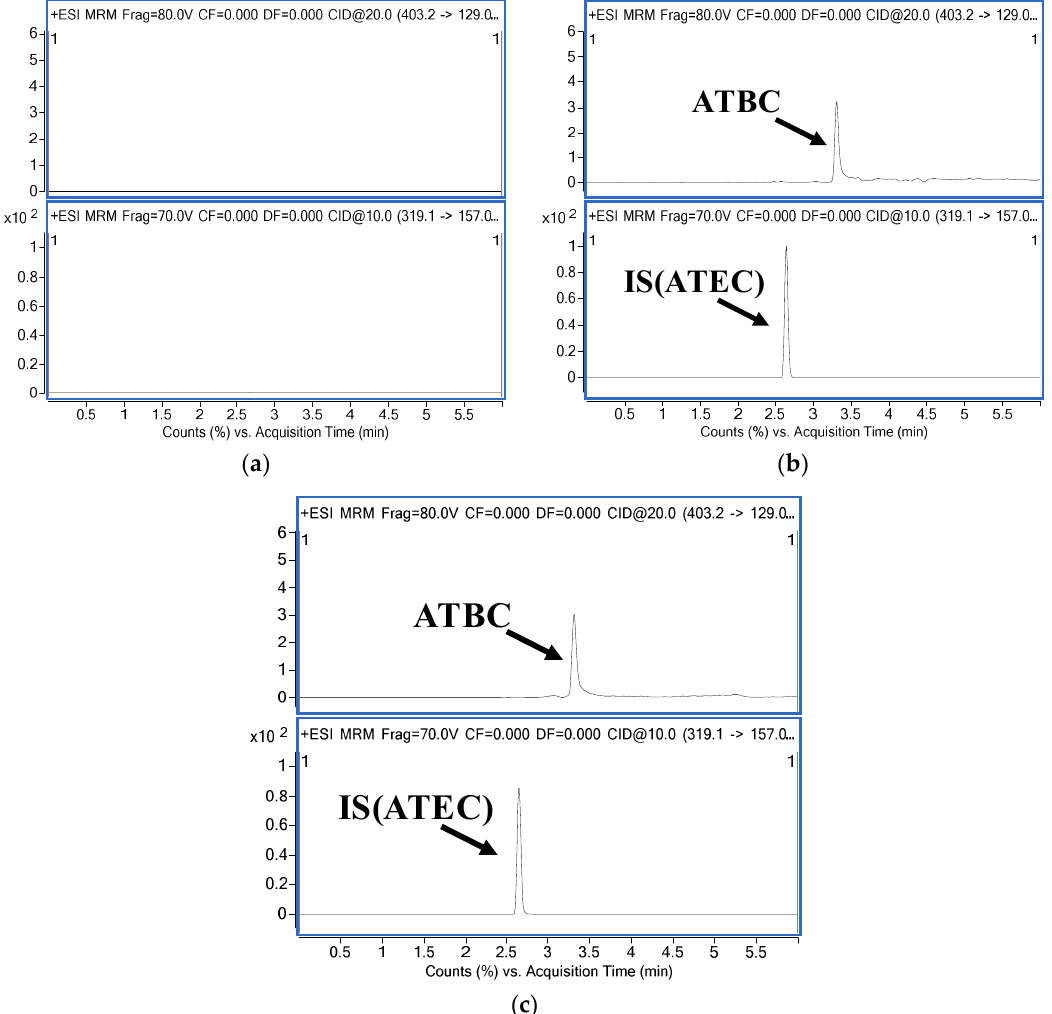
Figure 2. Representative multiple reaction monitoring (MRM) chromatograms of ATBC and IS (ATEC) in rat plasma. ( a ) blank plasma; ( b ) The lower limit of quantification (LLOQ) of ATBC at 10 ng/mL and IS at 100 ng/mL; ( c ) plasma sample at 10 h after oral (PO) administration of 500 mg/kg of ATBC.